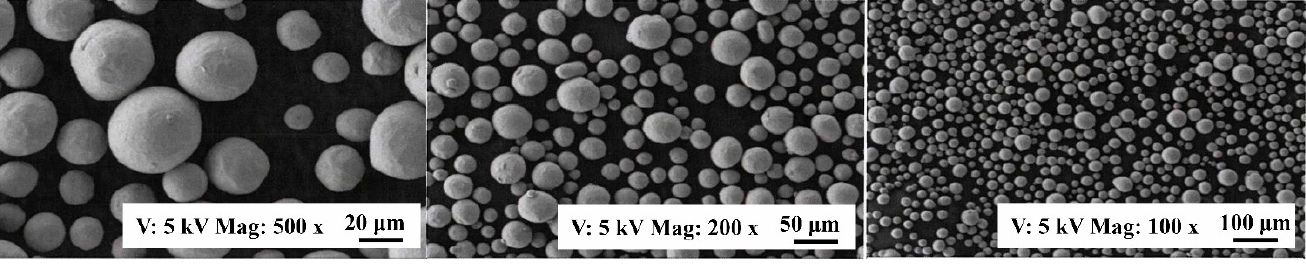
Figure 1. The SEM image of the TC4 powder. Table 1. The chemical composition of TC4 powder and workpiece.